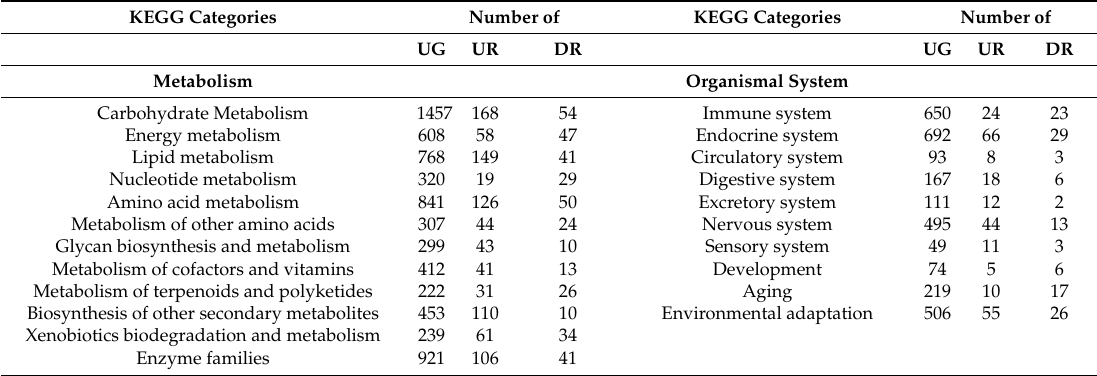
Figure 2. Gene Ontology (GO) terms assigned to the unigenes ( A ) and the differentially expressed genes ( B ). Table 2. Classification statistics for unigenes (UG) and differentially expressed genes (up-regulated (UR) and down-regulated genes (DR)) in CBCVd-infected hop plant according to Kyoto Encyclopedia of Genes and Genomes (KEGG) pathway